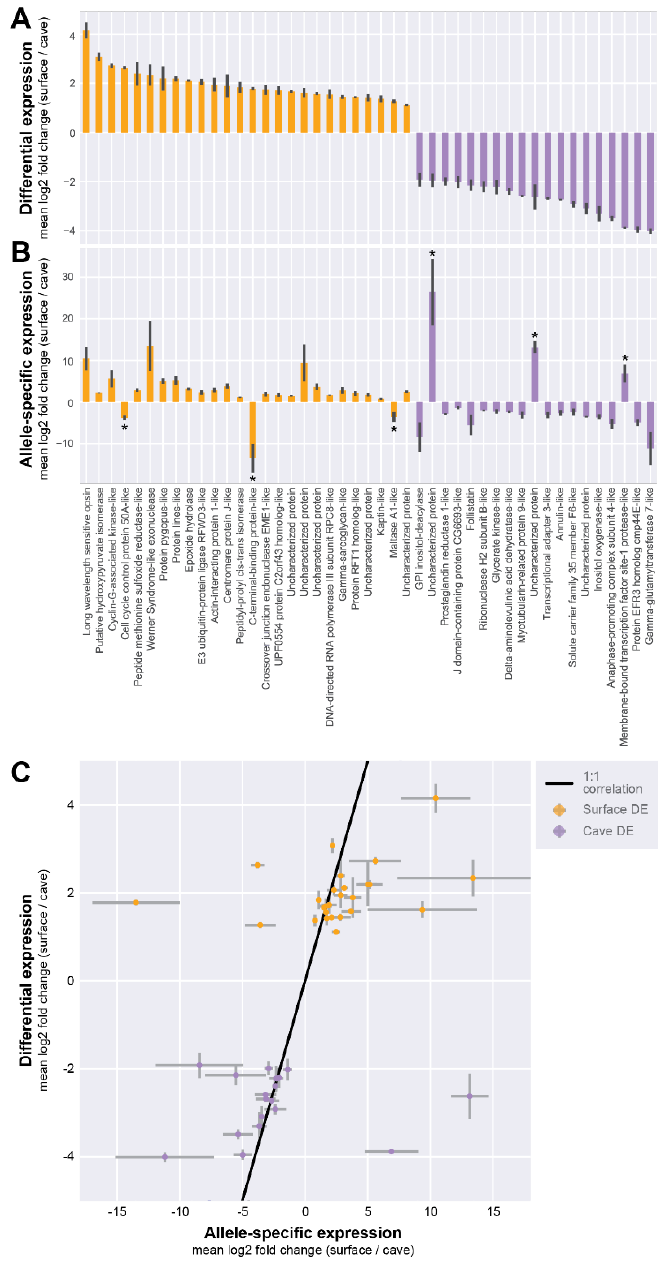
Figure 3. Allele-specific expression suggests cis-regulatory contribution to population di ff erence. ( A ) For the subset of genes that showed significant allele-specific expression, mean log2 fold change comparing surface and cave di ff erential expression. ( B ) Mean log2 fold change comparing surface allele and cave allele expression within the hybrid, in the same order as in ( A ). ( C ) A Spearman correlation test indicates that di ff erentially expressed (DE) and ASE analyses are significantly correlated (correlation = 0.5241, p -value = 2.197 × 10 − 4 ). Note: The gene with the highest allele-specific expression, an uncharacterized protein, was omitted from the scatter plot for ease of